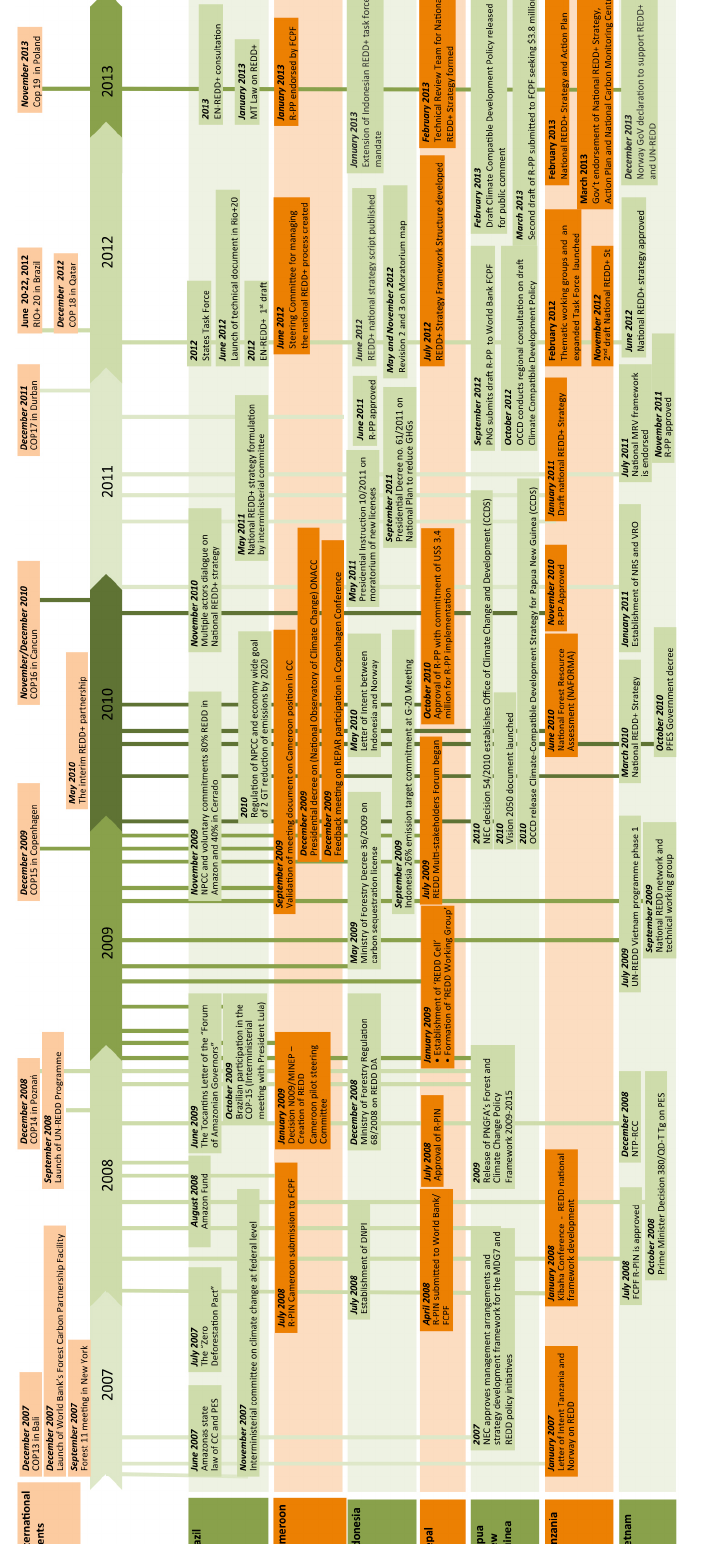
Fig. 1 . Key REDD+ policy events in seven